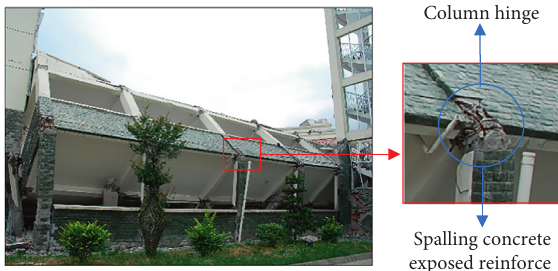
Figure 5: The final collapse state of Xuankou middle school teaching building (the pictures from author Dai Junwu).